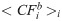
Fluctuations of the CGENM of long DNA sequences.Histograms of the average fluctuations, (a) < CF
i >i and < DF
i >i, (b) <CFib>i and <DFib>i, (c) <CFis>i and <DFis>i, and (d) <CFit>i, and <DFit>i, for nucleosome-forming and -inhibiting sequences of budding yeast Saccharomyces cerevisiae (150 bp). Helical parameter set (i) (Table 2) was used.